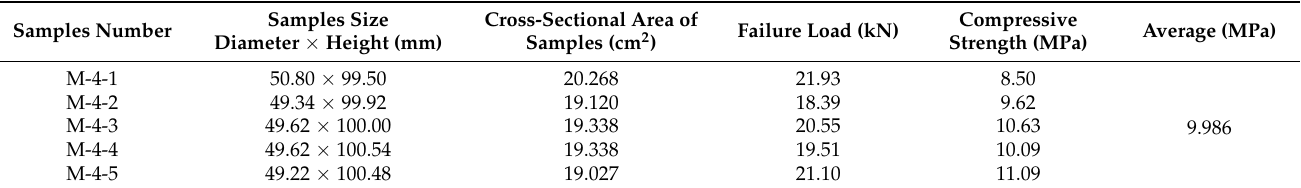
Table 1. Determination results of uniaxial compressive strength of coal samples. Samples Size Cross-Sectional Area of Samples Number Diameter × Height (mm) Samples (cm 2